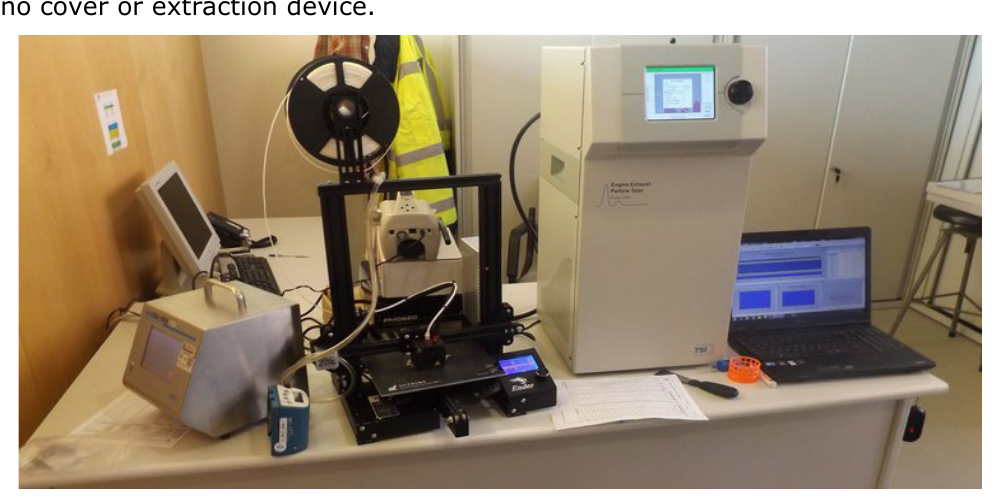
Figure 1. Ender 3D printer,